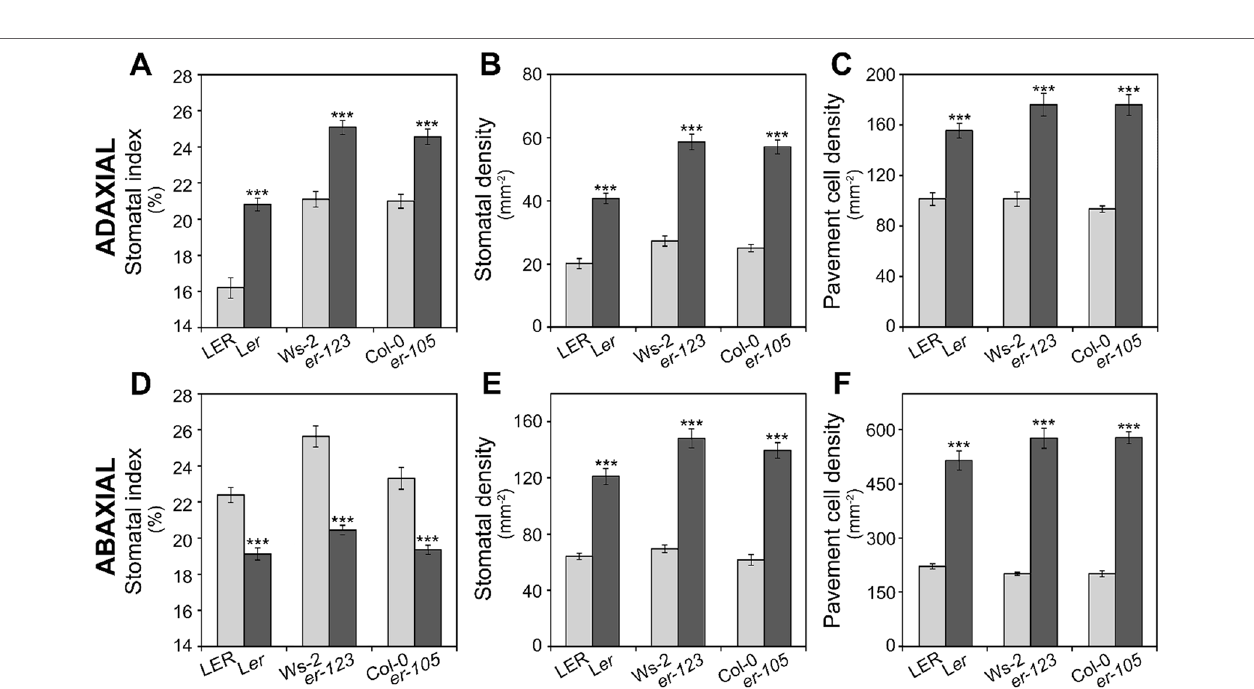
FIGURe 4 | Effect of erecta alleles on stomatal abundance traits in both cotyledon epidermis. Stomatal index and density and pavement cell density were scored in adaxial (A – C) or abaxial (D – F) cotyledon epidermis of indicated genotypes. L ER , Col-0, and Ws-2 carry wild-type ERECTA alleles, whereas L er , er-105 , and er-123 harbor dysfunctional erecta alleles. For each trait, the mean ± SE of 10–20 plants are presented. Asterisks indicate significant differences ( P ≤ 0.001; Student's t -test) between a given er mutant and the corresponding wild type.